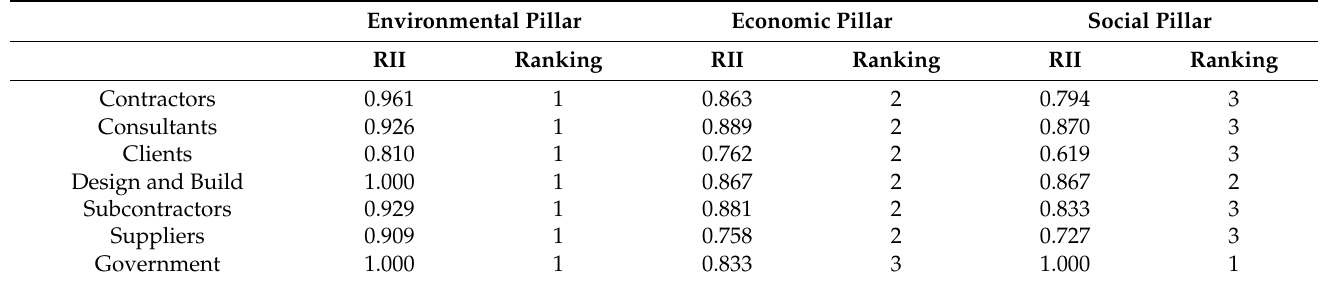
Table 11. Categorized RII ranking of the three pillars of sustainability in terms of their relevance to SC based on the respondents’ professional background.